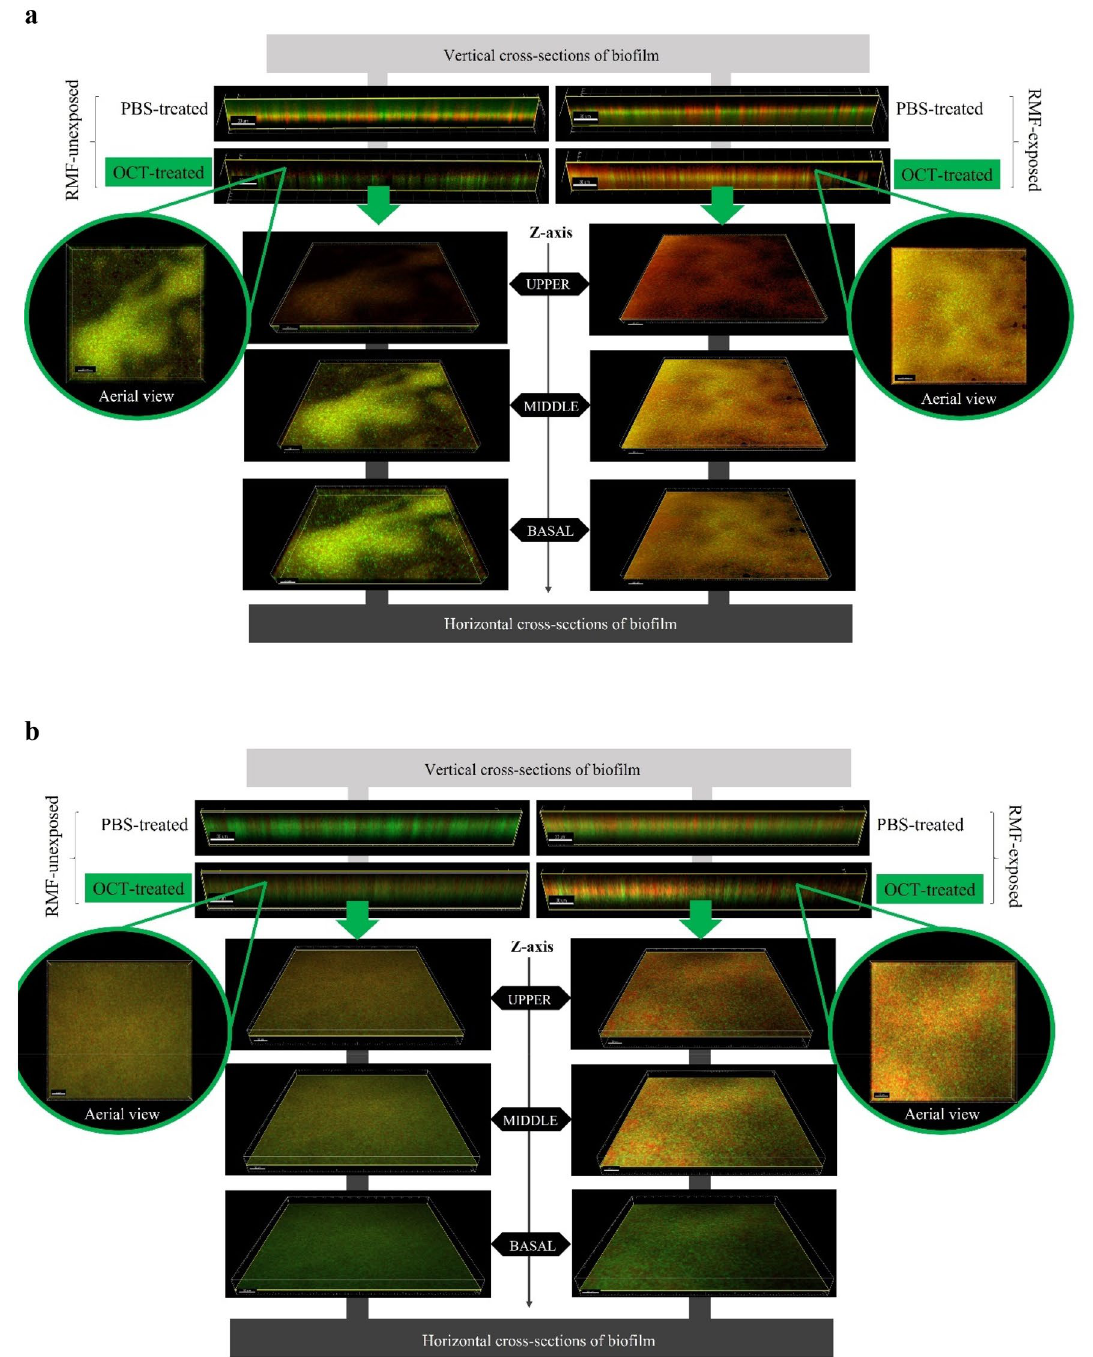
Figure 7. The spatial location of ( a ) staphylococcal and ( b ) pseudomonal cells within biofilm treated with OCT-saturated carriers and/or exposed to RMF (5 Hz). The cells with non-altered cell walls dye green (as a result of SYTO-9), while the cells with compromised cell walls dye red/orange (as a result of propidium-iodide reason, in the first stage of the study, it was confirmed that the application of antiseptic-saturated carrier did not translate into a drop of viable biofilm-forming cells of both S. aureus and P. aeruginosa bacterial species, on any of the agar discs (C, M, B) during the particular 3 h contact time. Simultaneously, the application of the same (with regard to antiseptic concentration) carriers reduced the percent of viable biofilm-forming cells when the contact time was exceeded over a 3 h period. The reduction in the number of live bacterial cells was particularly visible only in the case of biofilms incubated with antiseptic solutions for 24 h, which was most likely related to the relatively low concentration of the active substance applied solution and the acknowledged prolonged